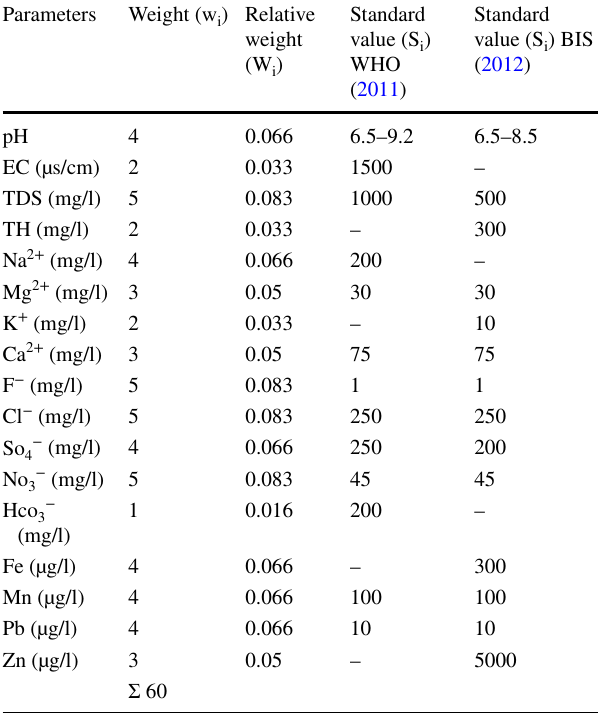
Table 1 Parameters, their weights, relative weights and standard val- ues of GWQI assessment (Vasanthavigar et al. 2010; Chakraborty et al. 2021a, b, c)